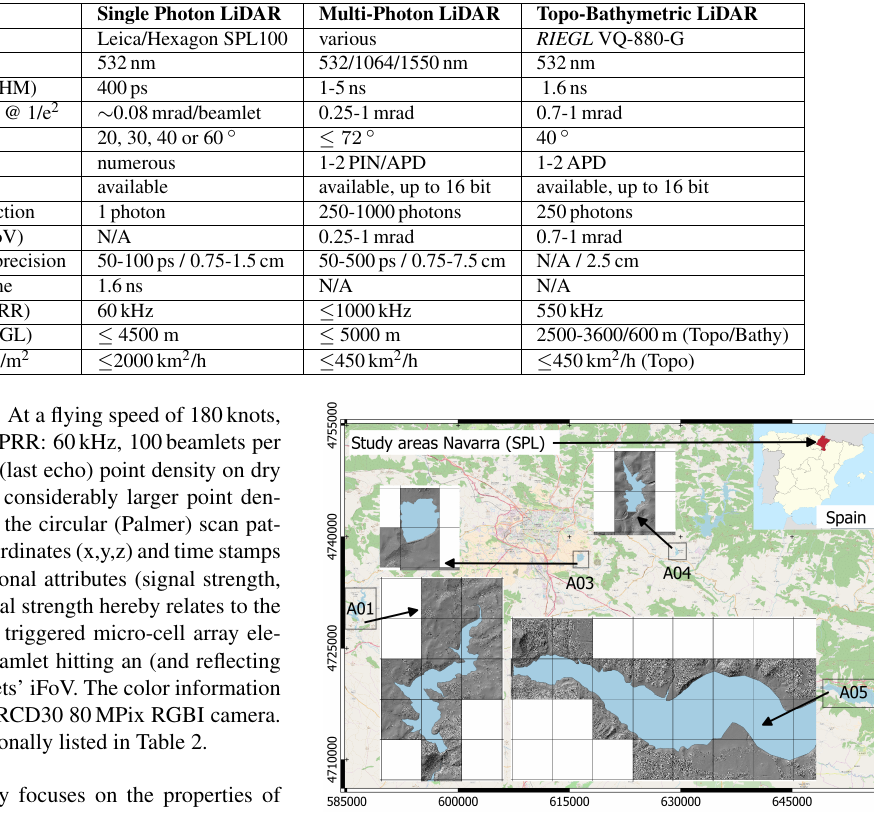
Table 1. Specifications for Single Photon LiDAR, Multi-Photon LiDAR, and Topo-Bathymetric LiDAR. For generalization purposes, a standard combination of specifications from various companies is provided for Multi-Photon LiDAR.